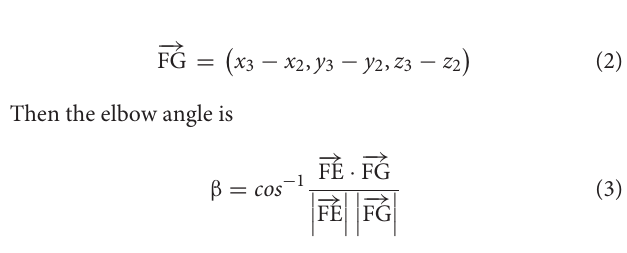
and the palm is upward in a horizontal relaxation state. Then